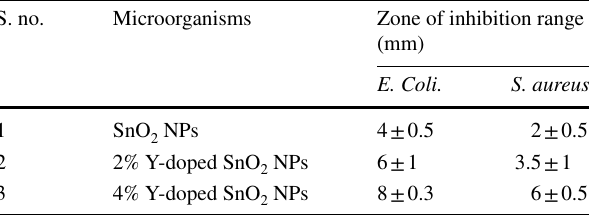
Table 2 Assessment of zone of inhibition of antibacterial activity for 100 μL of as-prepared nanoparticles S.